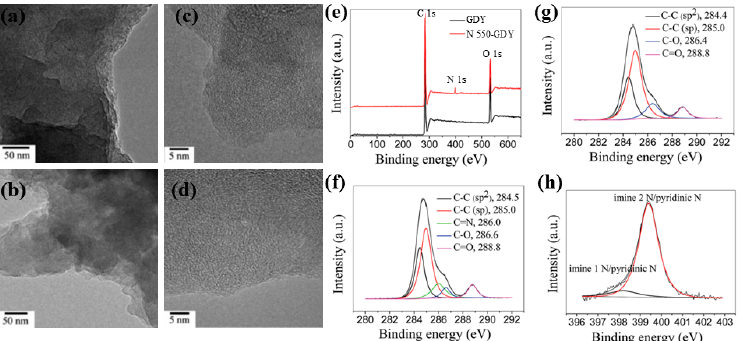
Figure 6. Structural characterizations of GDY and N–GDY. Transmission electron microscopy (TEM) images of ( a ) GDY and ( b ) N–GDY powder. HRTEM images of ( c ) GDY and ( d ) N–GDY powder; ( e ) X-ray photoelectron spectrometry (XPS) spectra (survey) of GDY and N–GDY. XPS C 1s spectra of ( f ) N–GDY and ( g ) GDY; ( h ) XPS N 1s spectrum of N–GDY. The C 1s peak of GDY can be split into four Lorentzian peaks at 284.4, 285.0, 286.4 and 288.8 eV [84–87] . The C 1s peak of N–GDY can be split into five Lorentzian peaks at 284.5, 285.0, 286, 286.6 and 288.8 eV [84,85] . The N 1s peak can be split into two Lorentzian peaks at 398.2 and 399.4 eV (reproduced with permission from [83] . Copyright The Royal Society of Chemistry, 2014).